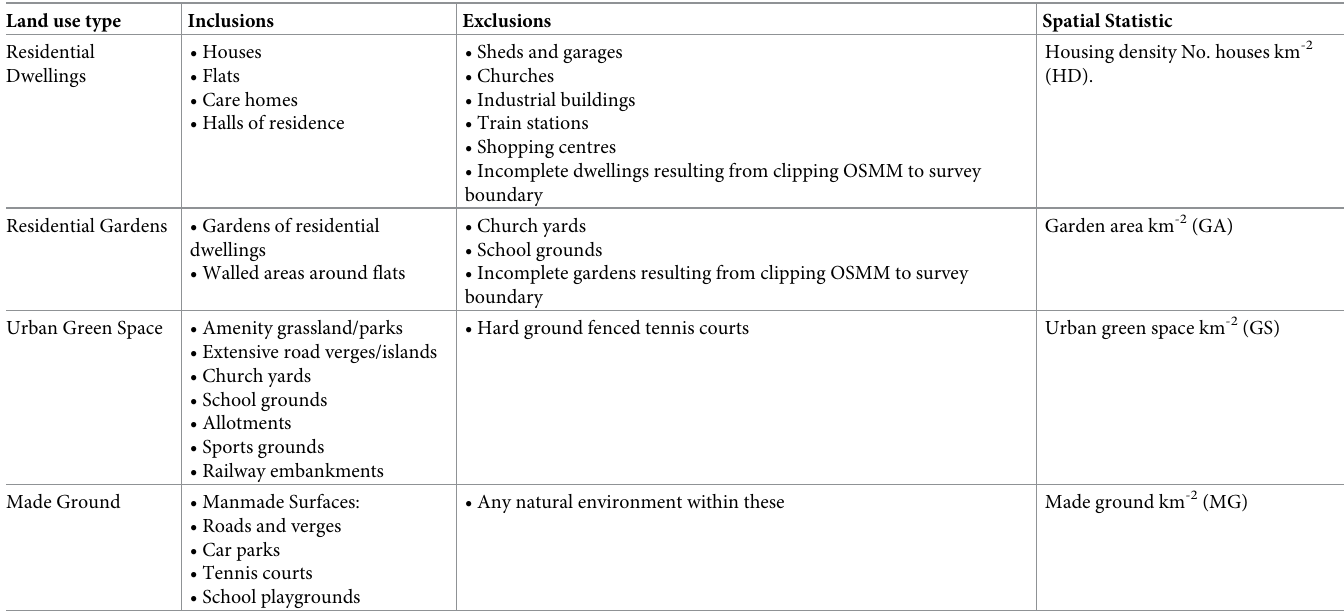
Table 1. Land use types, features included and excluded and spatial